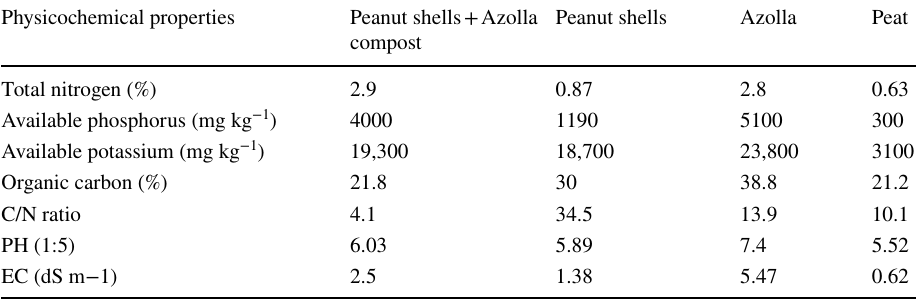
Table 2 Some physicochemical properties of peanut shells + Azolla compost, peanut shells, Azolla, and peat